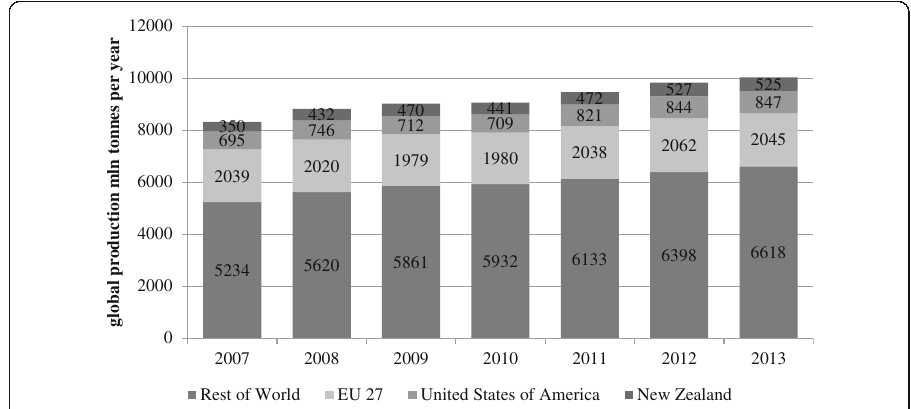
Fig. 3 Global butter production from 2005 to 2013. Source: International Dairy Federation